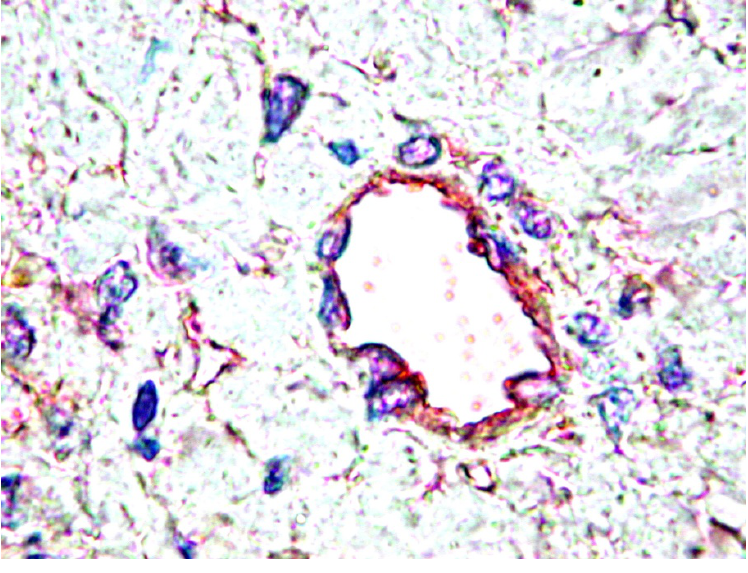
Figure 1. Double immunostaining for PDGF (red) and PDGFR-beta (brown, arrows). Original magnification,